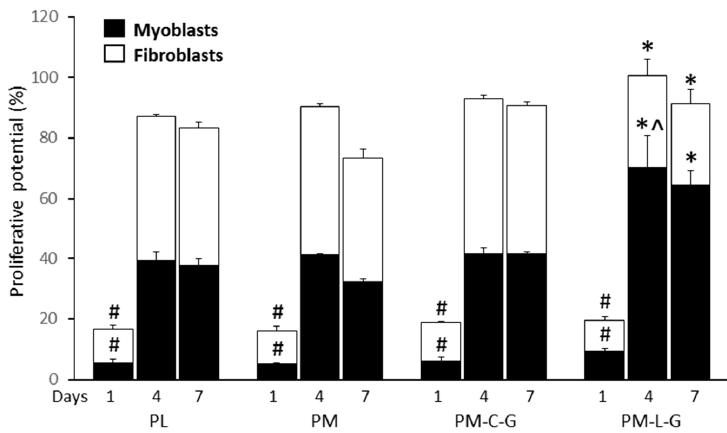
Figure 8. Proliferative potential of fibroblast and myoblasts. # indicates significance difference between groups; * indicates a significant difference between fibroblasts/myoblasts from different culture conditions on the same day; ^ indicates a significant difference between myoblasts in PM-L-G with other culture conditions.